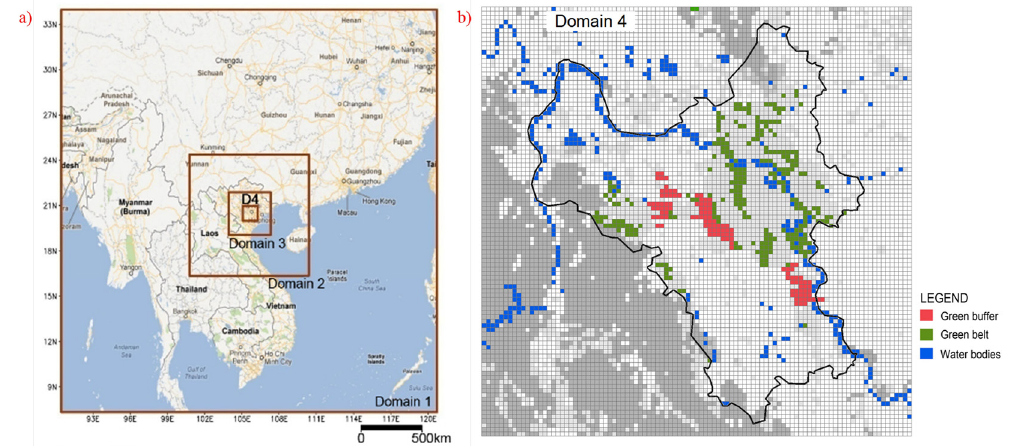
Figure 2. ( a ) Computational domains for the Weather Research and Forecasting (WRF) simulation. ( b ) Domain 4 covers all of Hanoi City (100 × 100 grid points), with 1 km resolution. The green strategy areas are indicated by colors. Green represents the green belts and red is for the green